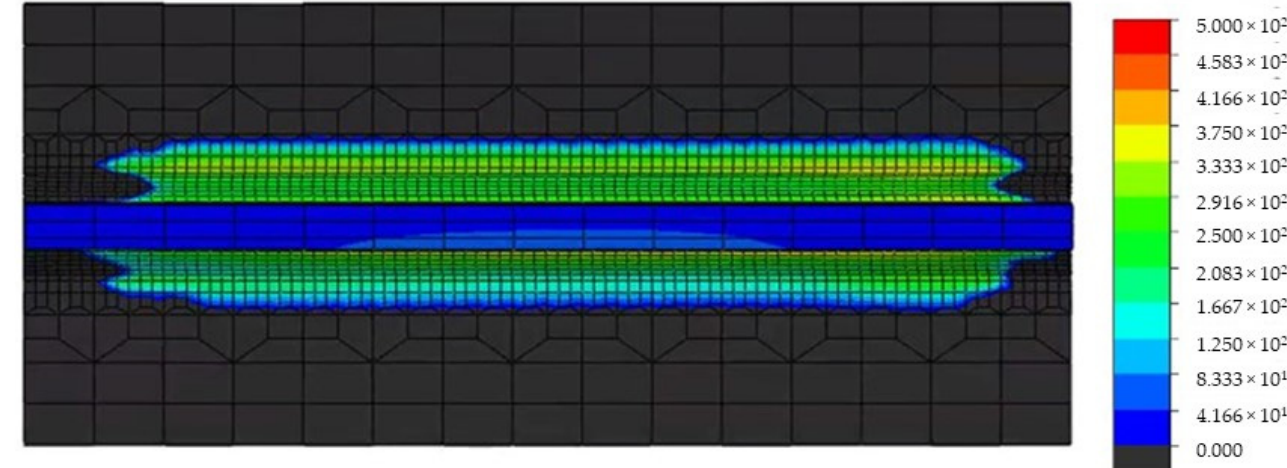
Figure 22. Main principal stress cloud of residual stress (unit: MPa). The initial crack was therefore placed in the residual compressive stress region at either the start or end of the weld joint in order to study the influence of residual compressive stress on crack propagation. The maximum displacement of the cyclic load was 0.35 mm, and the initial crack size was shown as in Figure 14. The crack propagation patterns in the length and thickness directions with and without the residual stress field are shown in Figures 23 and 24 for the cracks in the start and end of the weld, respectively.